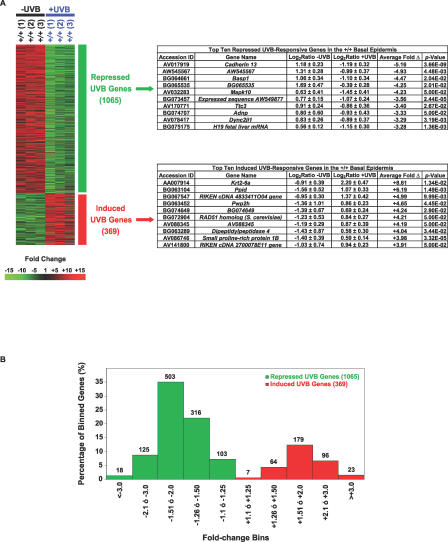
UVB Transcriptional Profile in the Basal Epidermis of Normal (+/+) P2.5 Mice(A) Heatmap of UVB-responsive genes. The ordered columns represent replicate samples of sham- (black) and UVB- (blue) irradiated mice, and the rows represent log2 ratios for 1,434 UVB-responsive genes. Data are displayed as a pseudocolor heatmap where red, green, and black represent induction, repression, and no change, respectively, relative to the median. Gray represents missing data. The ratio fold-change is indicated by a scale bar. Genes are ranked by their average fold change (Δ) value. The average fold Δ value was obtained by dividing the average expression level of each gene in the experimental (UVB-irradiated) group by that in the control (sham-irradiated) group. Average expression levels for the experimental and control groups are represented as log2 ratios ±SEM. The top ten ranked genes for the repressed and induced responses are listed along with their corresponding average fold change (Δ) and Student's t-test p-values. In some cases, official mouse gene symbols are used, instead of the lengthier gene names.(B) Distribution of fold-change differences for UVB-responsive genes. Fold-change differences were obtained by comparing sham- and UVB-irradiated mice. Data were binned into one of five fold-change classes for each of the repressed and induced responses. The total number of genes sorted into each bin is shown above each class.